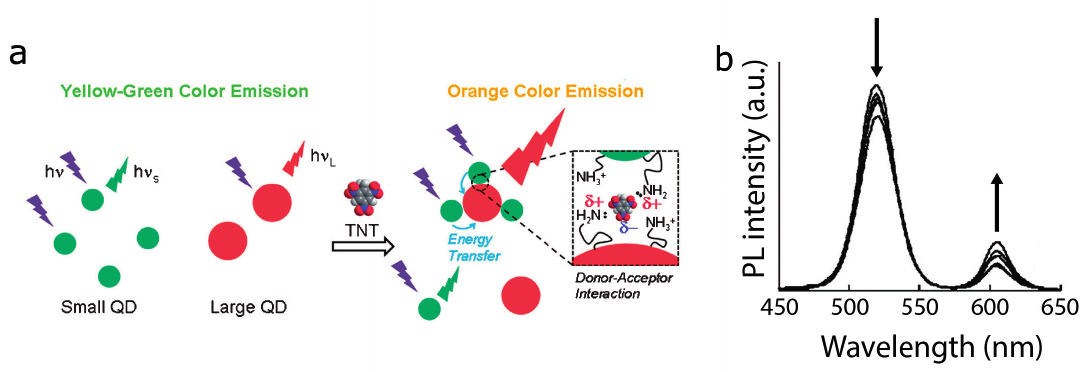
Figure 10. ( a ) Schematic of the TNT sensor by Shiraki et al . Positive charges from the amino groups on the QD surface ligands interact with negative charges on the TNT molecule, causing the QDs to aggregate. Schematic is not drawn to scale; ( b ) PL spectra of the sensor with both sizes of QD populations. The arrows indicate how the PL intensity of the donor and acceptors change with increasing analyte concentration. (b) reprinted with permission from